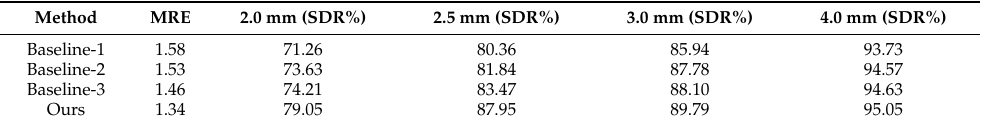
Table 4. Ablation study results of Baseline-1, Baseline-2, Baseline-3 and our shooting reward learning in ISBI2015 test set 2 (measured by MRE and SDR).